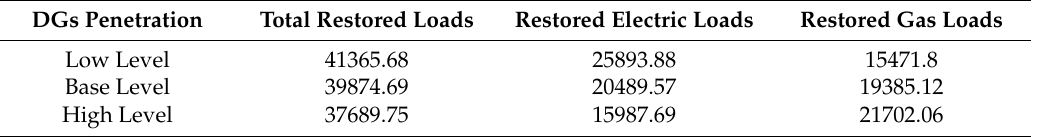
Table 11. Results of restoration under di ff erent DGs penetration.